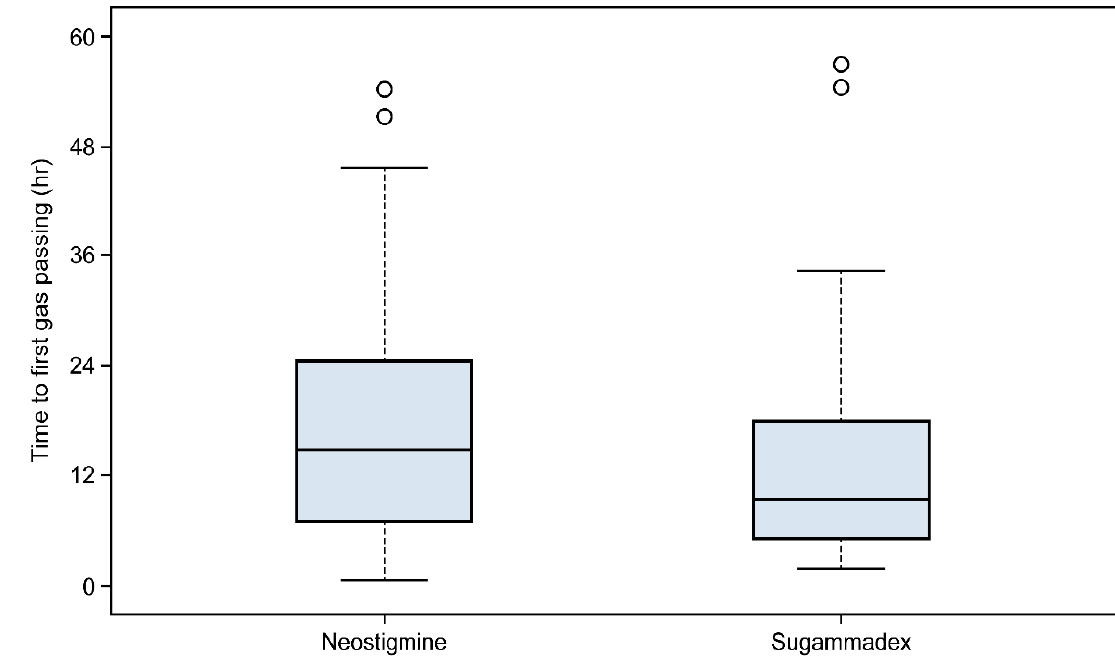
Figure 2. Distribution of the Wilcoxon scores for gas-passing time (h) after the operation in the neostigmine group ( n = 62) and sugammadex group ( n = 46). Table 3. Postoperative bowel motility. Table 4. Univariate and multivariate logistic regression analyses of the prognostic factors for the gas emission time within 24 h after robotic thyroidectomy ( n =